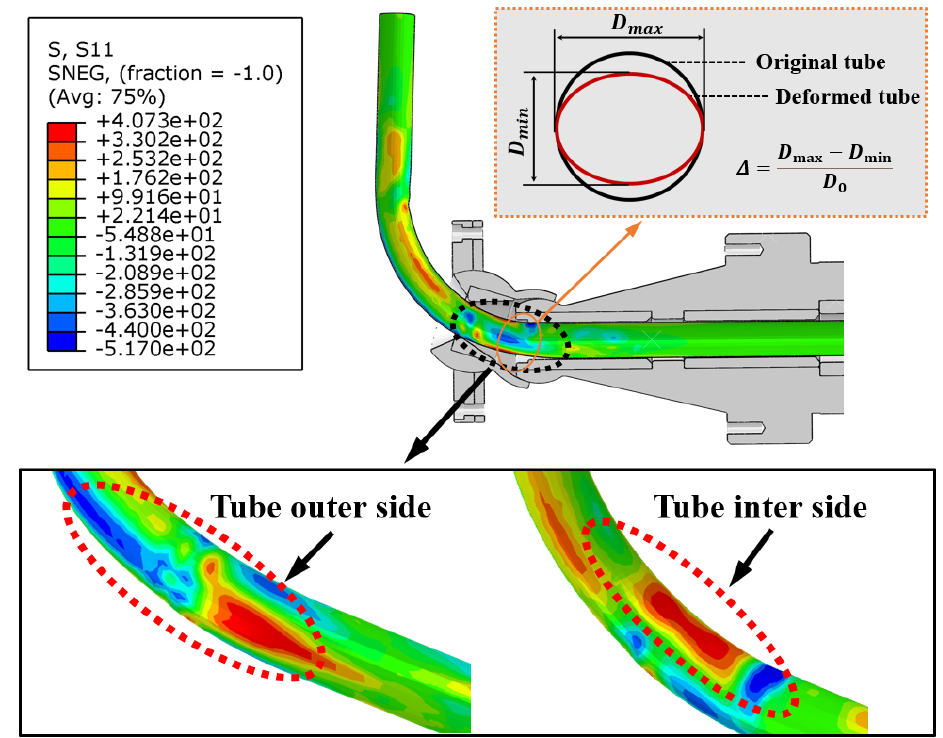
Figure 7. The distribution of radial stresses in 3D free bending simulation.